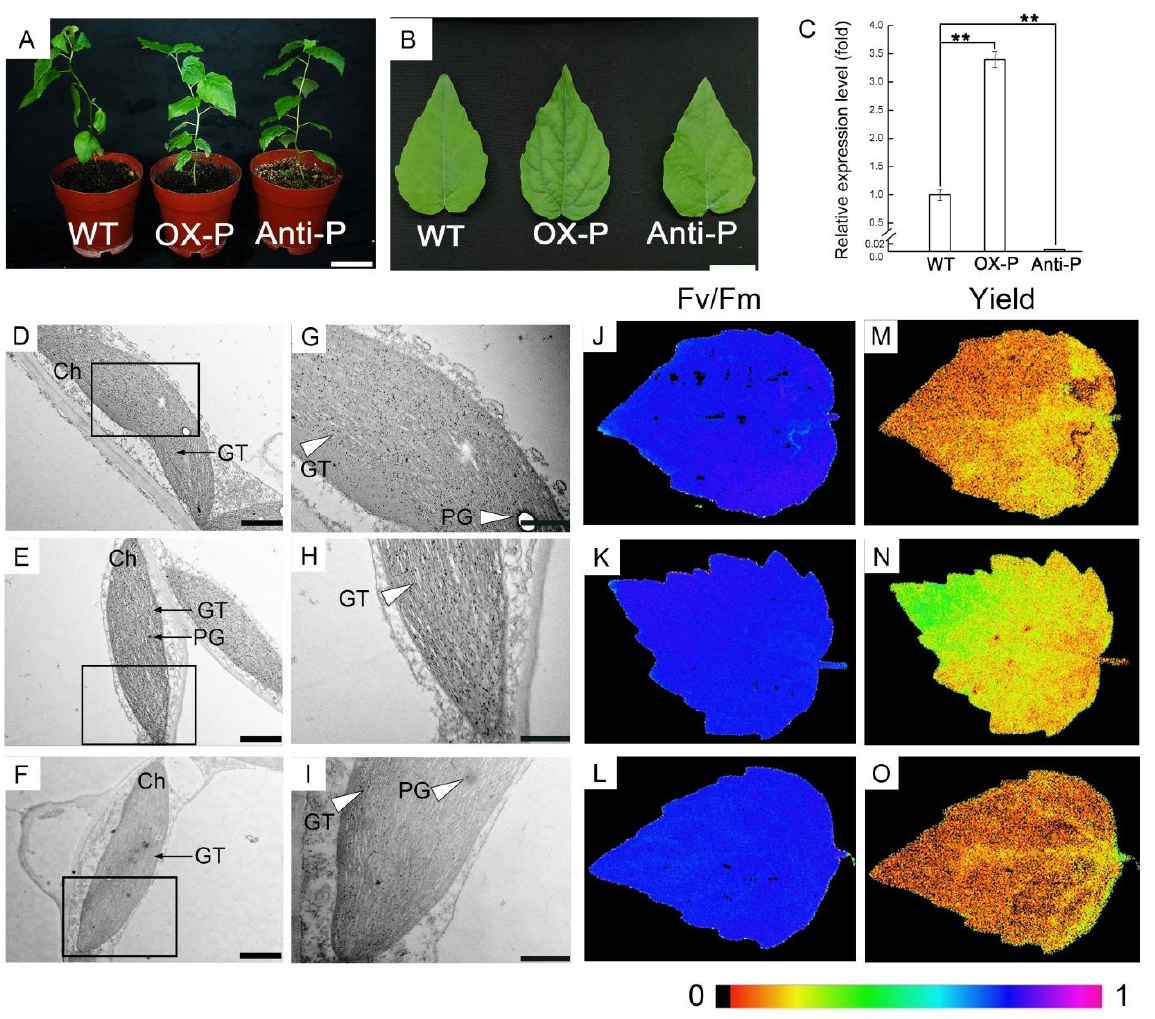
Figure 1. Phenotype, subcellular structure and the change in chloroplast oxidant or reduced contents in transgenic P. tomentosa . ( A , B ), Growth of transgenic P. tomentosa. ( A ), Bar = 10 cm; ( B ), Bar = 2 cm. ( C ), qRT-PCR of PtotAPX. OX-P, overexpression-transgenic P. tomentosa ; anti-P, antisense-expression transgenic P. tomentosa . Values are means ± SD ( n = 3). Significant differences between mean values are indicated by asterisks using Student’s t -test. ** and * indicate p < 0.01 and p < 0.05, respectively. ( D – I ), Ultrastructural images of chloroplast in leaves. ( D ) and ( G ), WT; ( E ) and ( H ), OX-P; ( F ) and ( I ), anti-P. GT, grana thylakoid; Ch, chloroplast; PG, plastoglobule. ( D – F ), Bar = 1 μ m; ( G – I ), Bar = 500 nm. ( G – I ), white arrowheads mark the partial enlarged views of thylakoids in WT, OX-P and anti-P (left), respectively. ( J – O ), PSII quantum yield and maximum efficiency of PSII (Fv/Fm). The false color scale is given on the bottom. ( J – L ), maximum efficiency of PSII (Fv/Fm). ( M – O ), PSII quantum yield. ( J ) and ( M ), WT; ( K ) and ( N ), OX-P; ( L ) and ( O ), anti-P. The false color means the spatial distribution of Fv/Fm values and yield ranged from black (0.0) to purple (1.0)